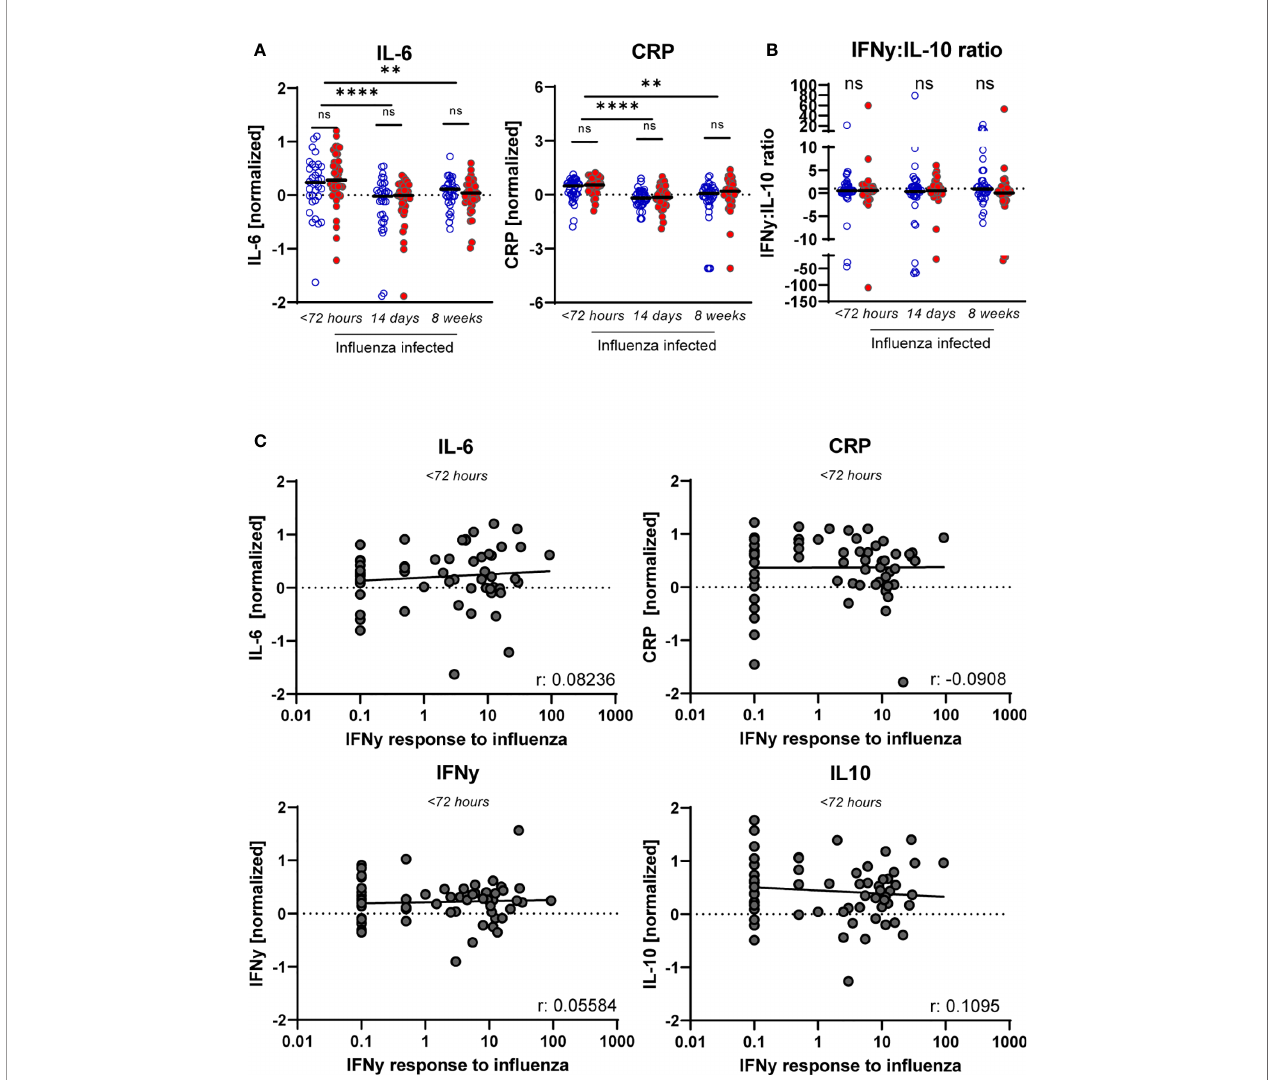
FIGURE 4 | No sign of increased in fl ammation in CMV + individuals based on cytokines levels in serum nor in relation to the IAV-speci fi c T-cell response. (A) Serum levels of “ in fl ammaging markers ” CRP and IL-6 upon in fl uenza infection for CMV + and CMV - individuals at < 72 hours after fever onset, and 2 and 8 weeks later. (B) The IFN g :IL-10 ratio for CMV - and CMV + individuals upon in fl uenza infection. (C) Magnitude of the IAV-speci fi c IFN g response at < 72 hours upon infection with in fl uenza virus are not associated with the level of CRP, IL-6, IFN g or IL-10 in serum. Serum levels of the cytokines were measured by multiplex assays and normalized based on subtracting the mean per plate. Differences were tested using unpaired T-test to compare CMV - and CMV + individuals. Correlations between IAV-speci fi c IFN g response and the different cytokines levels in serum were assessed by Spearman correlation. T-cell IFN g responses are presented per 1 x 10 6 PBMCs. **P < 0.01, ****P < 0.0001. ns, non signi fi